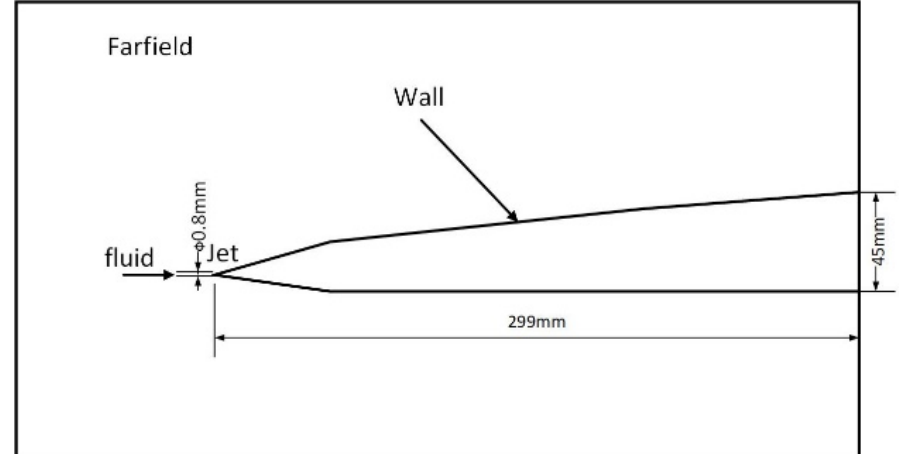
Figure 13. Schematic diagram of lifting body structure.